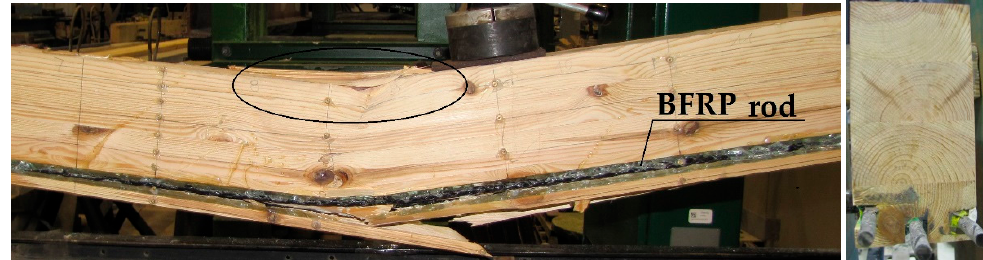
Figure 13. Crushing of the Wa-B1 beam’s compressed zone and the destruction of the stretched zone near wood flaws (photograph by Wdowiak).